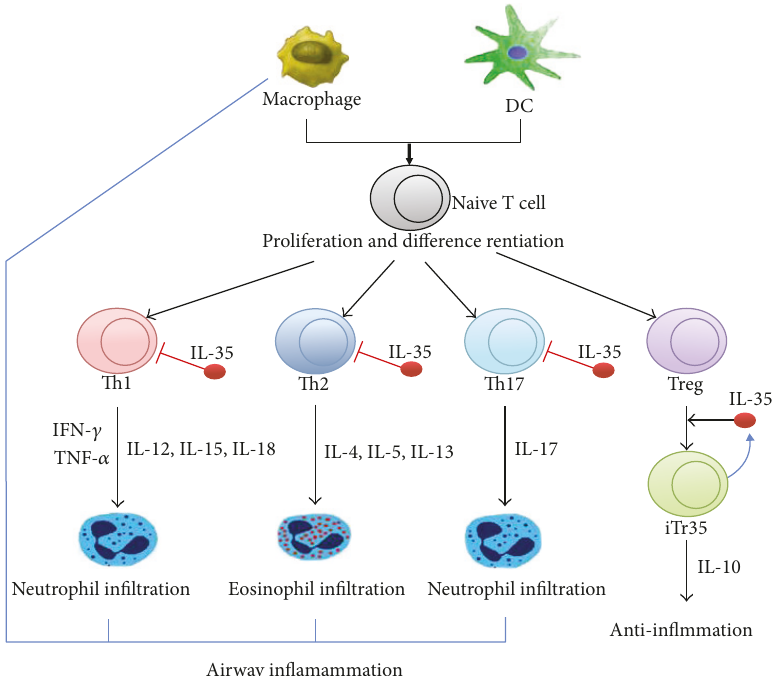
Figure 2: Function of IL-35 in asthma. The black arrow indicates positive e ff ects, and the T-shaped end indicates negative e ff ects. DC: dendritic cell; IL: interleukin; Th: helper T cell. Adapted from Pope and Shahrara